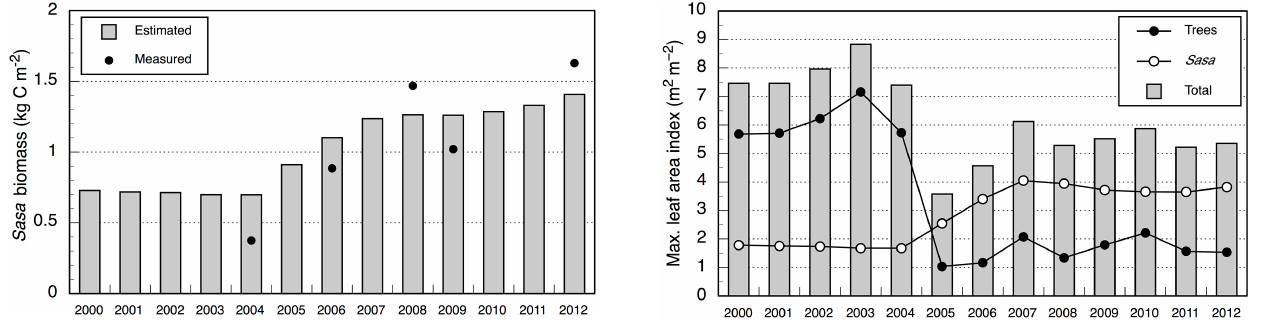
Figure 7. Interannual changes in maximum leaf area index in the canopy tree and dwarf bamboo ( Sasa kurilensis and S. senanensis ). Each of them is estimated from the light